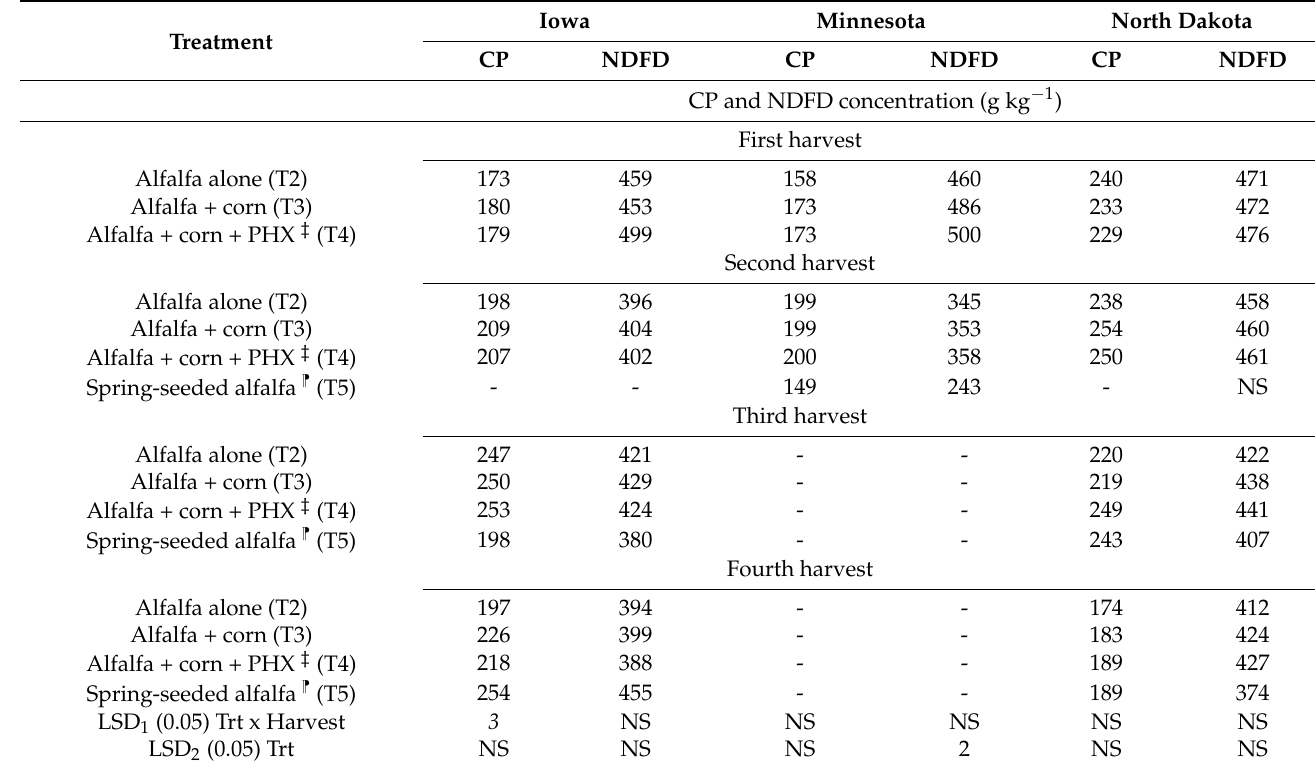
Table 11. Forage nutritive value analysis, crude protein (CP) and neutral detergent fiber digestibility (NDFD) for each harvest and treatment in the first production year † .